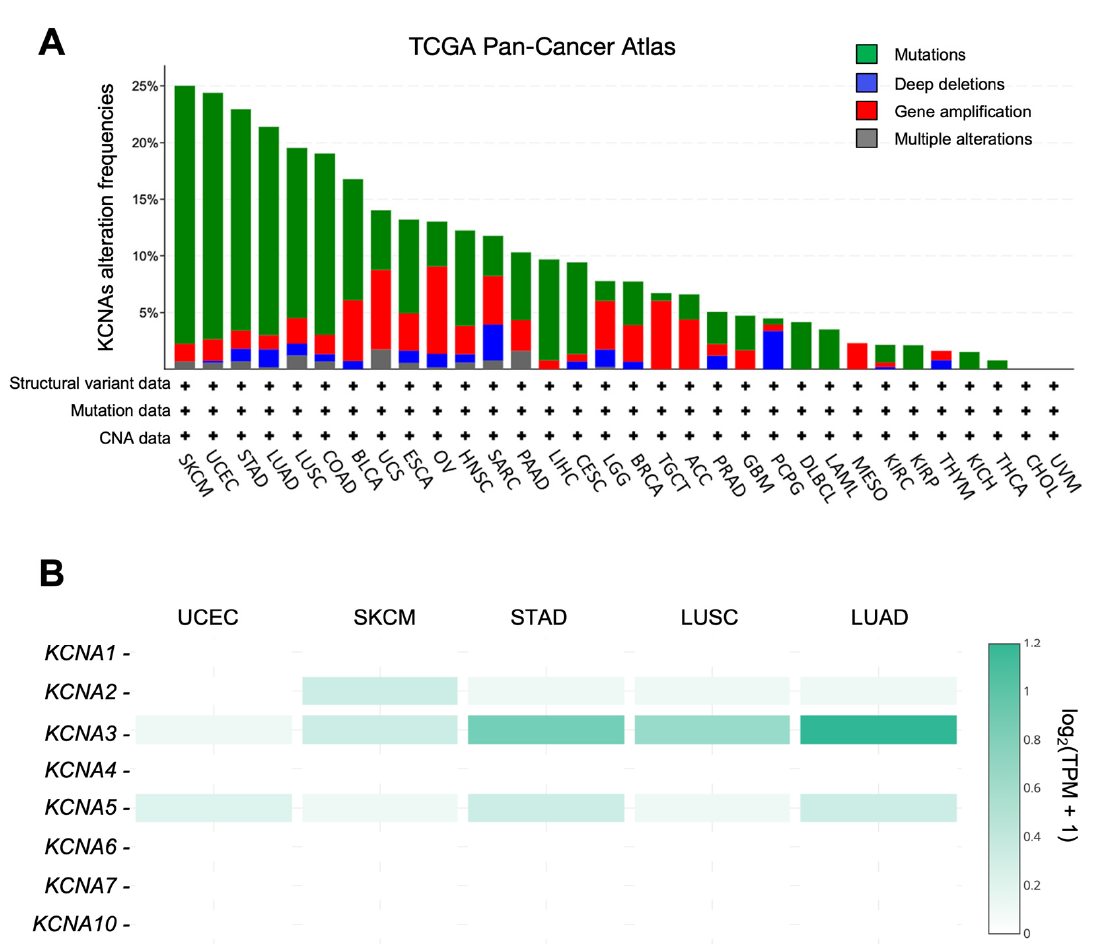
Figure 1. Genomic alteration frequencies and differential expression of KCNAs family in human cancers. ( A ) Mutation frequencies of KCNAs in 32 cancer studies were retrieved from cBioPortal (TCGA Pan-Cancer Atlas dataset). Cancer names list: ACC: Adrenocortical carcinoma; BLCA: Blad- der Urothelial Carcinoma; BRCA: Breast invasive carcinoma; CESC: Cervical squamous cell